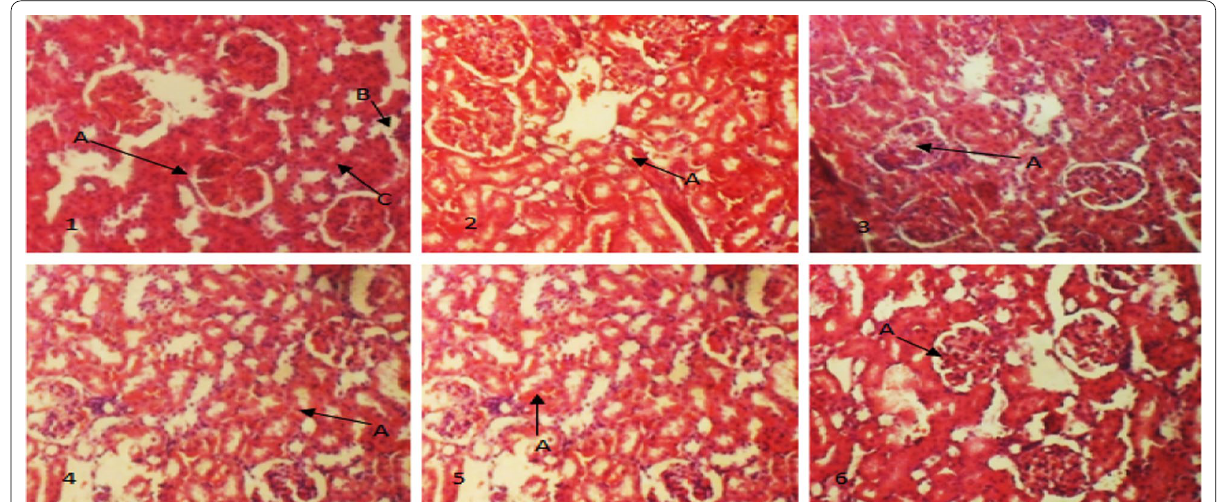
Fig. 13 Effect of n-hexane leaf extract of Ipomoea batatas L . on kidney. (1) Control rat kidney composed of A—glomerulus, B—tubules and C—interstitial space, (2) phenylhydrazine administered alone showed A—focal vascular intimal erosion, (3) at 5 mg/kg of ferrous (iii) hydroxide poly-maltose showed A—mild interstitial congestion, (4) 125 mg/kg n-hexane extract showed A, mild interstitial congestion (5) 250 mg/kg n-hexane extract showed A, mild interstitial congestion and (6) 500 mg/kg n-hexane extract showed A, normal renal architecture in the kidney. Using haematoxylin–eosin dye with X 40